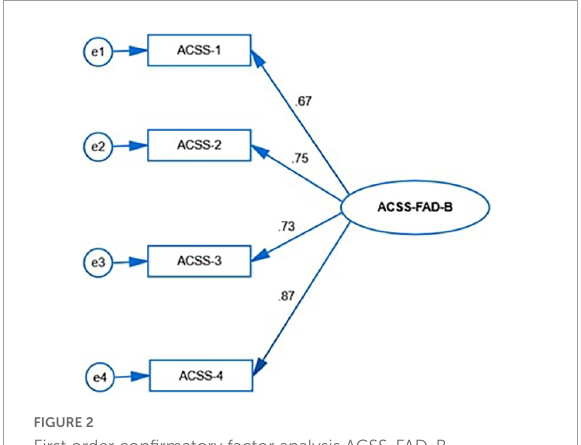
FIGURE2 First order confirmatory factor analysis